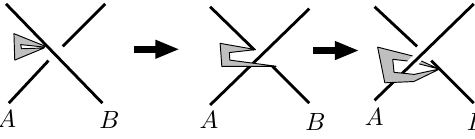
Fig. 12. TopoIA acts if A and B are single strings. TopoII acts if A and B are double strings.